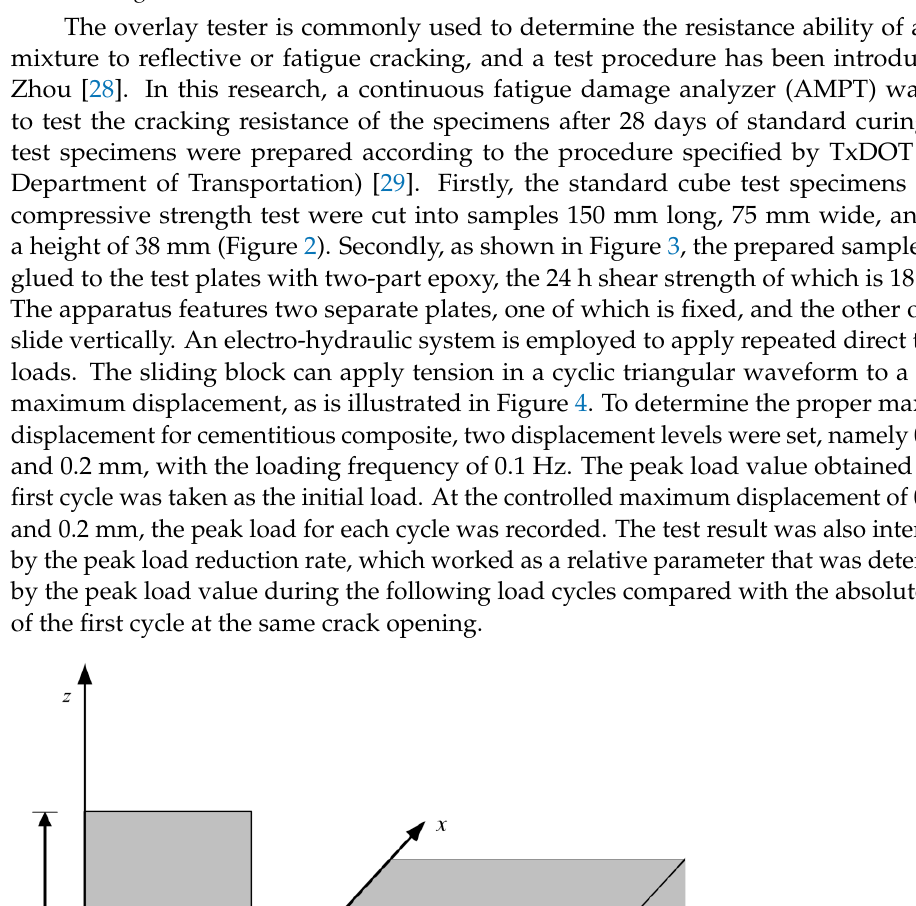
Figure 3. Installment of specimen. Figure 4. Schematic of test sequence. Note: At a maximum crack opening of 0.2 mm, the total number of cycles is 60. 4.2. Drop-Weight Impact Loading Test As presented in Figure 5, the impact loading test was carried out in accordance with ASTM Standards D 1557, with a minor revision that replaced the mold with a cramping apparatus to fix the concrete specimen during testing. The mass of the mechanical rammer is 4.5364 ± 0.009 kg, the drop height (H) from the highest point to the lowest point is 67 cm, and it can drop freely from a certain height following the height of the specimens. Suppose the thickness (T) of the specimen is known. In that case, the impact energy can be calculated by Equation (1). Therefore, the impact resistance performance of different specimens can be evaluated by the number of impacts of the concrete specimens. r